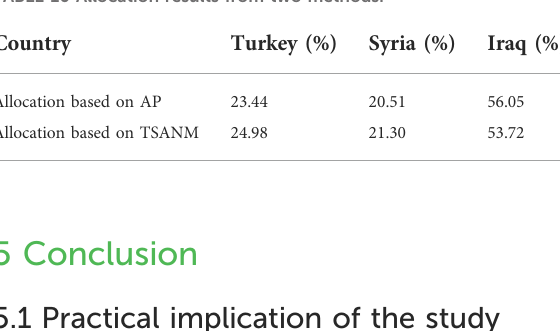
TABLE 10 Allocation results from two